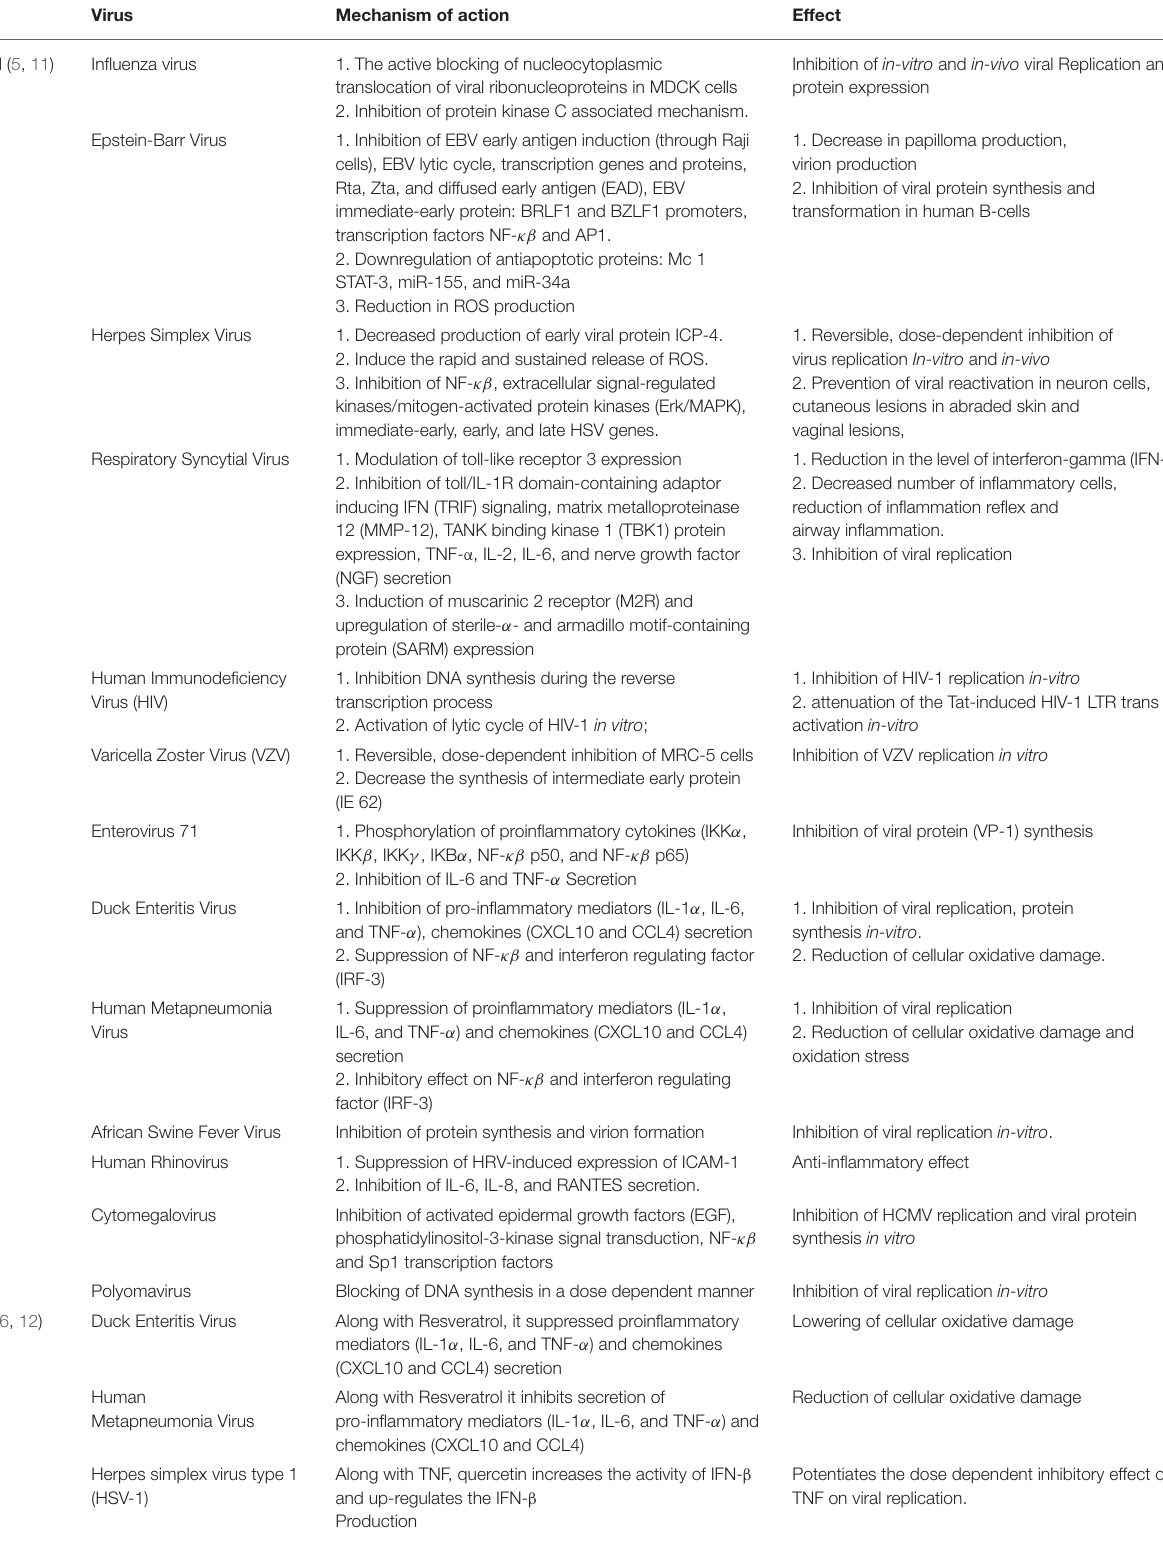
TABLE 1 | Compilation of antiviral properties and effects of selected nutraceuticals.